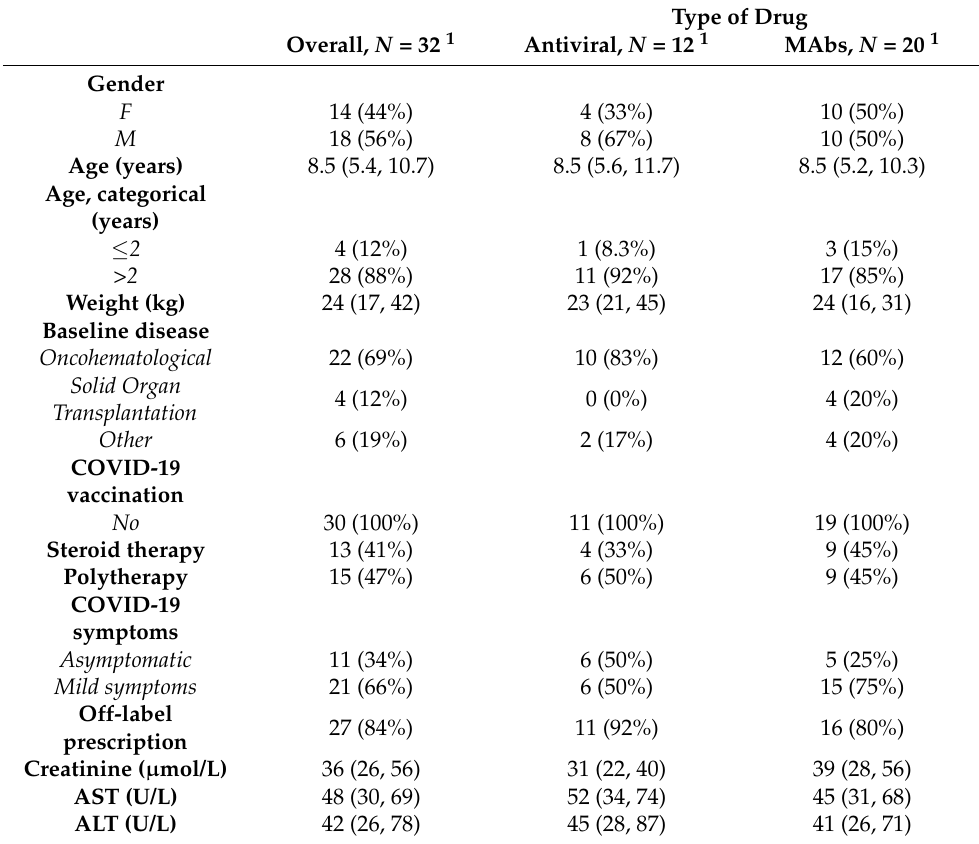
Table 2. Baseline characteristics according to the administered